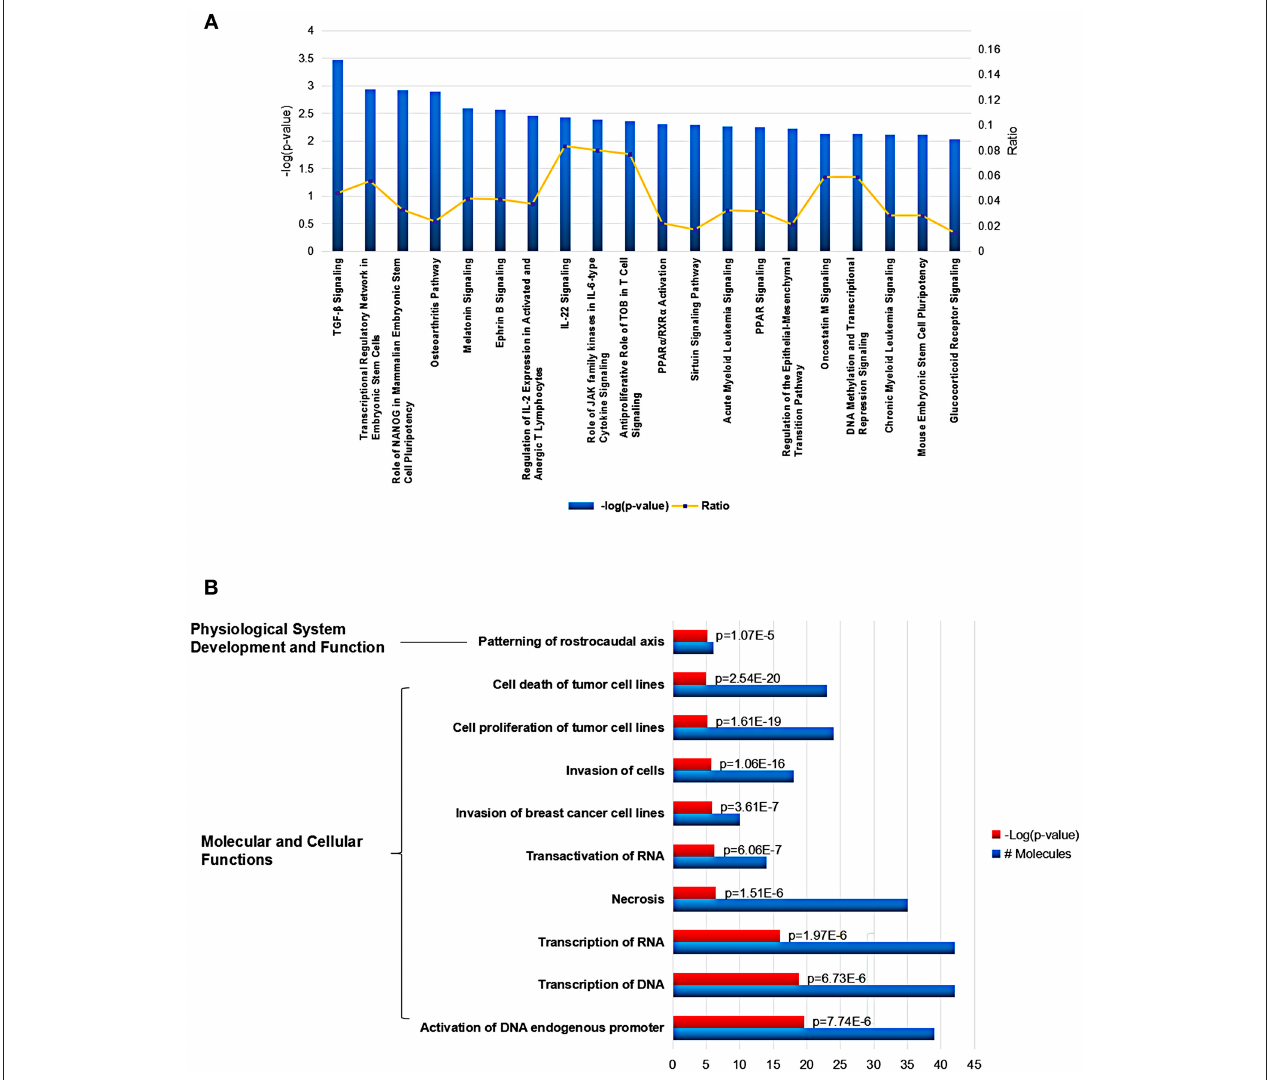
FIGURE 4 | Cellular function and pathway analysis of the global Mtb interactors using IPA software. (A) The IPA canonical pathway analysis showed 20 significantly changed pathways ( p -value < 0.05). (B) The top-10 significantly changed items covered the two IPA categories including the “Molecular and Cellular Functions,” and “Physiological System Development and